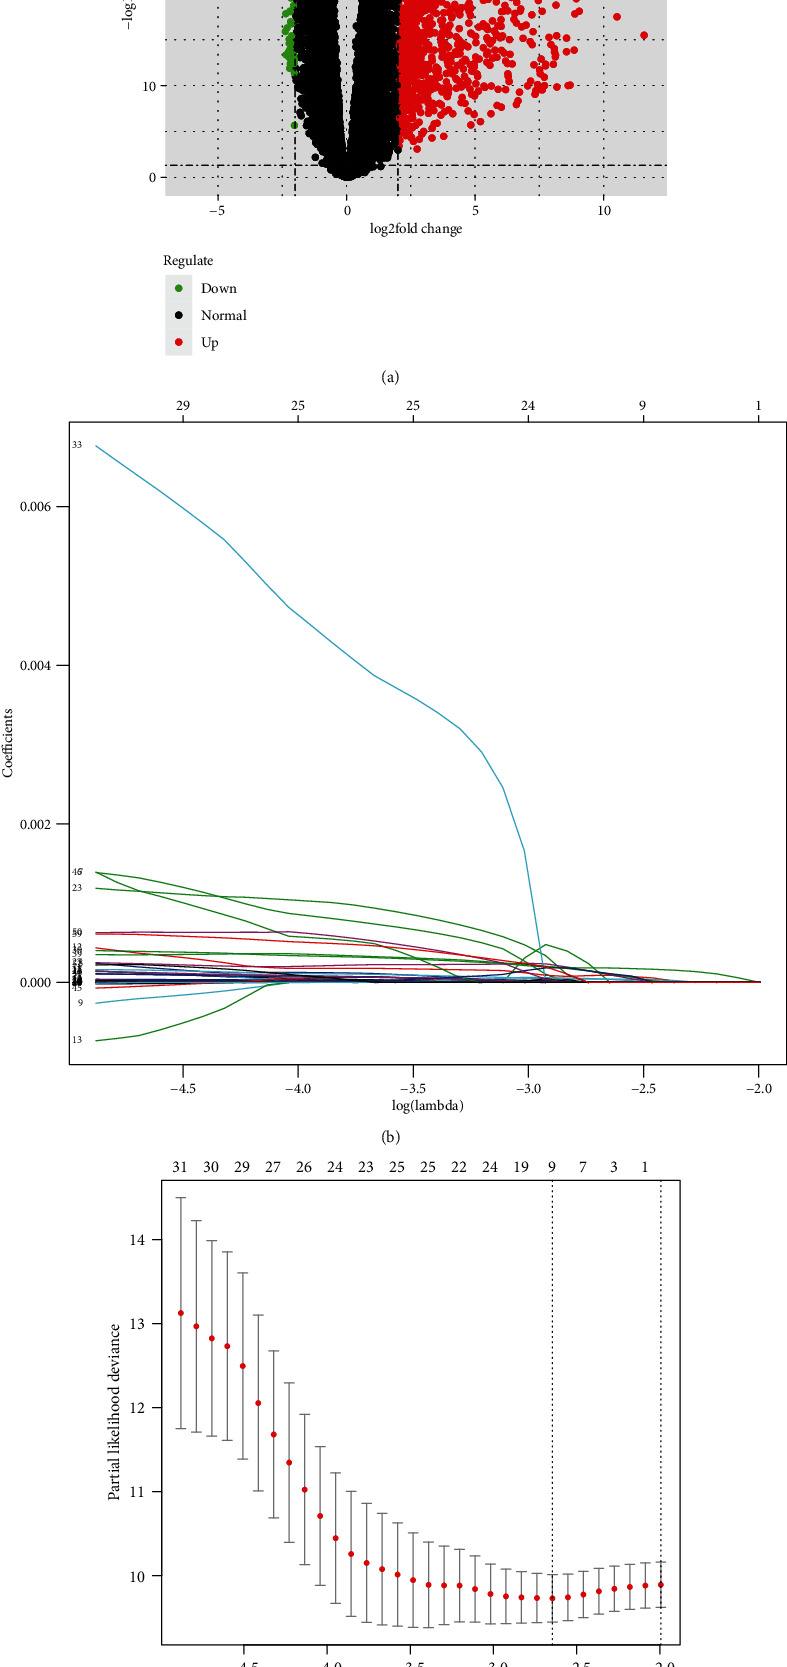
Candidate gene selection. (a) Volcano plot of the DEGs in the TCGA-LUAD dataset; (b) regression coefficients in Lasso regression analysis; (c) selection of lambda in the Lasso regression model through 10-fold crossvalidation method.